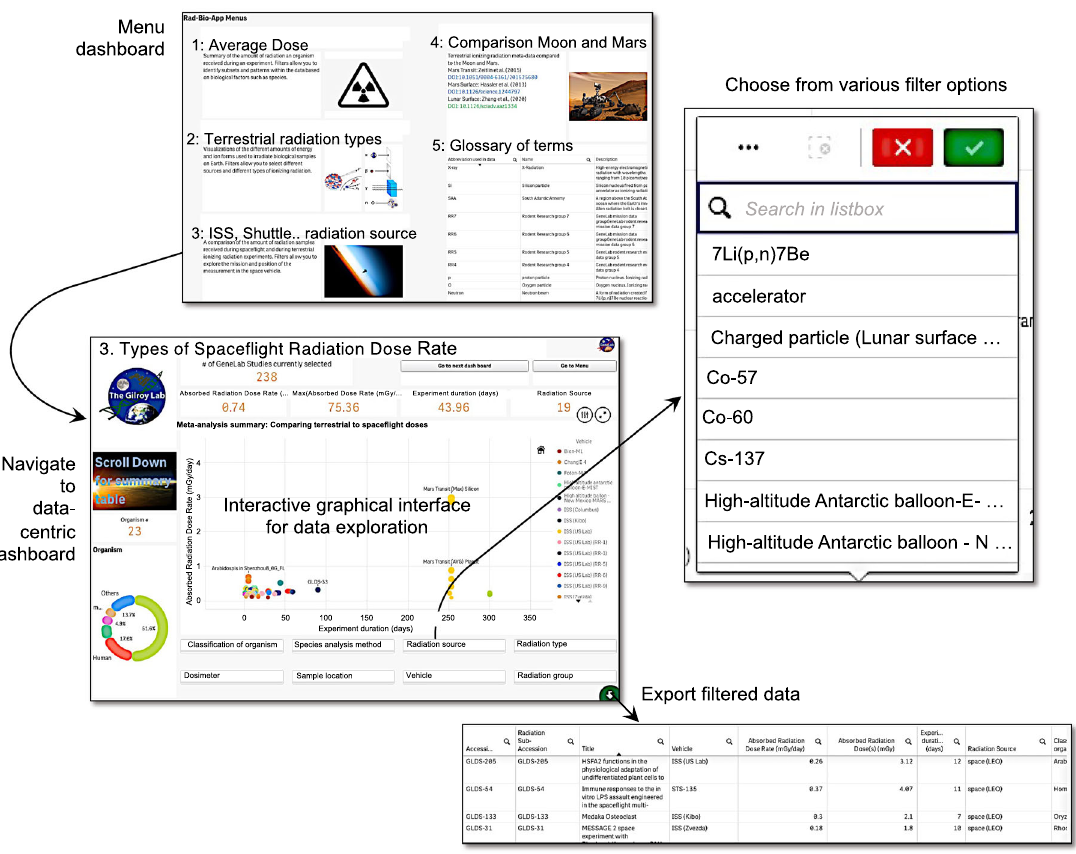
Fig. 4 Navigation within Rad-Bio-App is through dashboards accessed from a central menu page. Each data exploration dashboard allows for reiterative, interactive fi ltering on factors such as radiation type, mission, and space fl ight hardware and allows for both dynamic visualization of the fi lter effects and for export of the fi ltered data to a